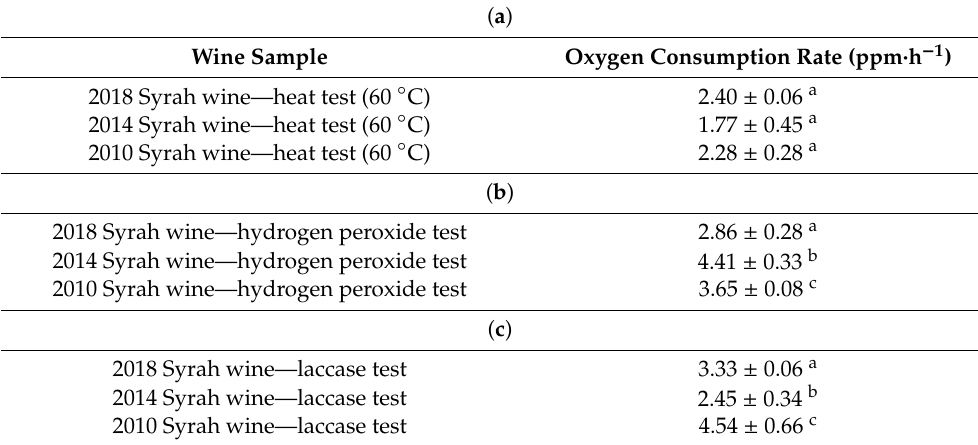
Table 2. Dissolved oxygen consumption rates for three di ff erent oxidized wines: ( a ) at 60 ◦ C; ( b ) with a hydrogen peroxide solution; ( c ) with a laccase solution. Means with di ff erent lowercase letters are significantly di ff erent (Tukey test, α =